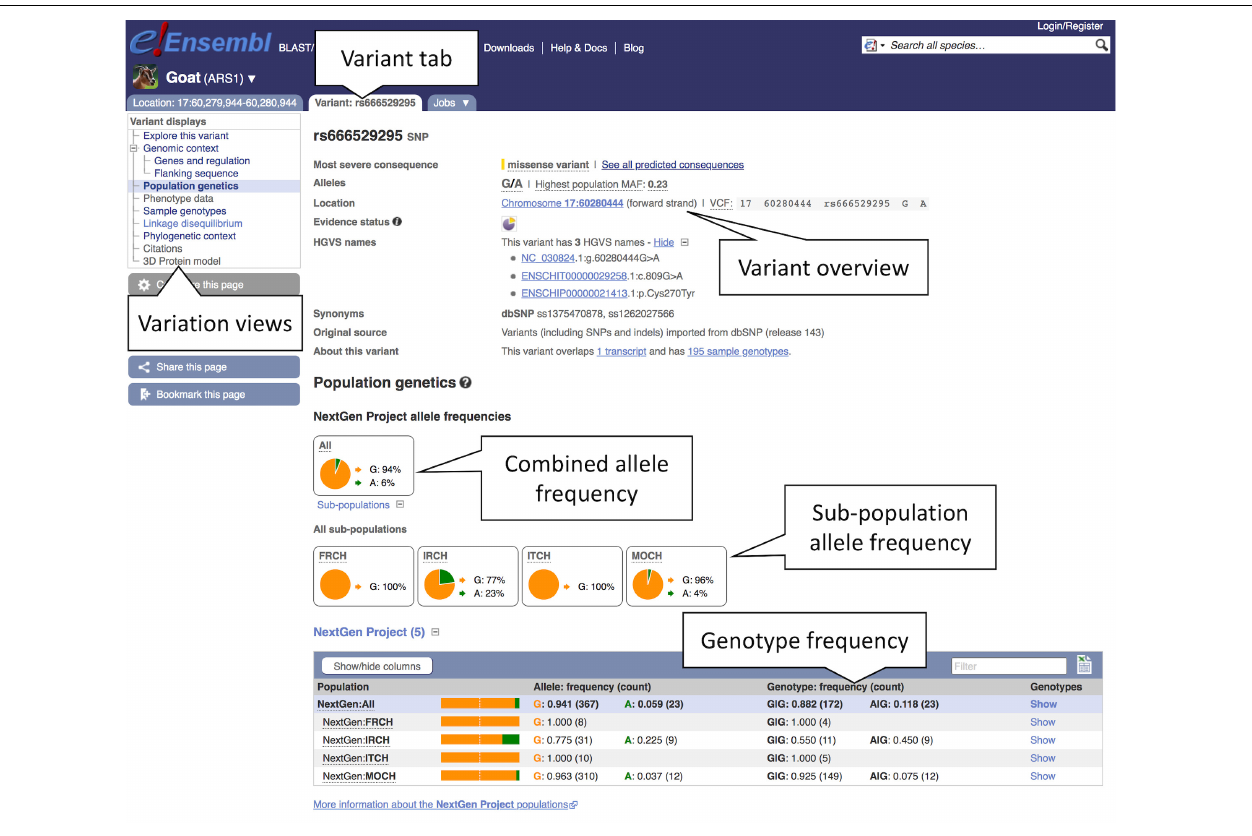
FIGURE 6 | Exploring variation data in goat. Here, we see the view of population genetics data within the variant tab. Pie charts for the overall allele frequencies along with frequencies for subpopulations are provided based off the NextGen Project data.